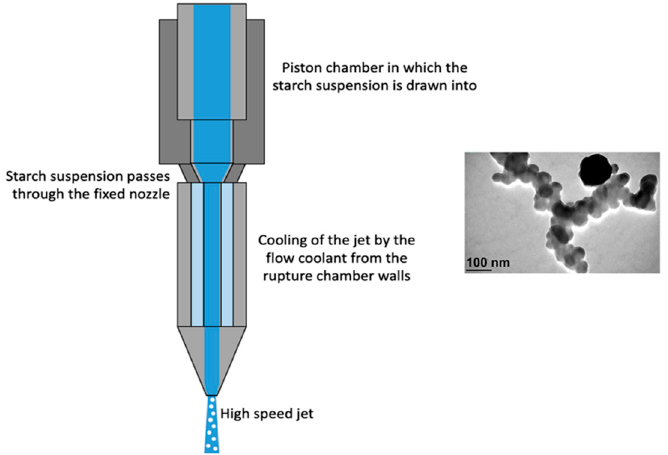
Figure 10. Synthesis of SNPs by high-speed jet method and TEM micrograph of tapioca SNPs. Reprinted from [71] with permission from Elsevier. Copyright (2020).